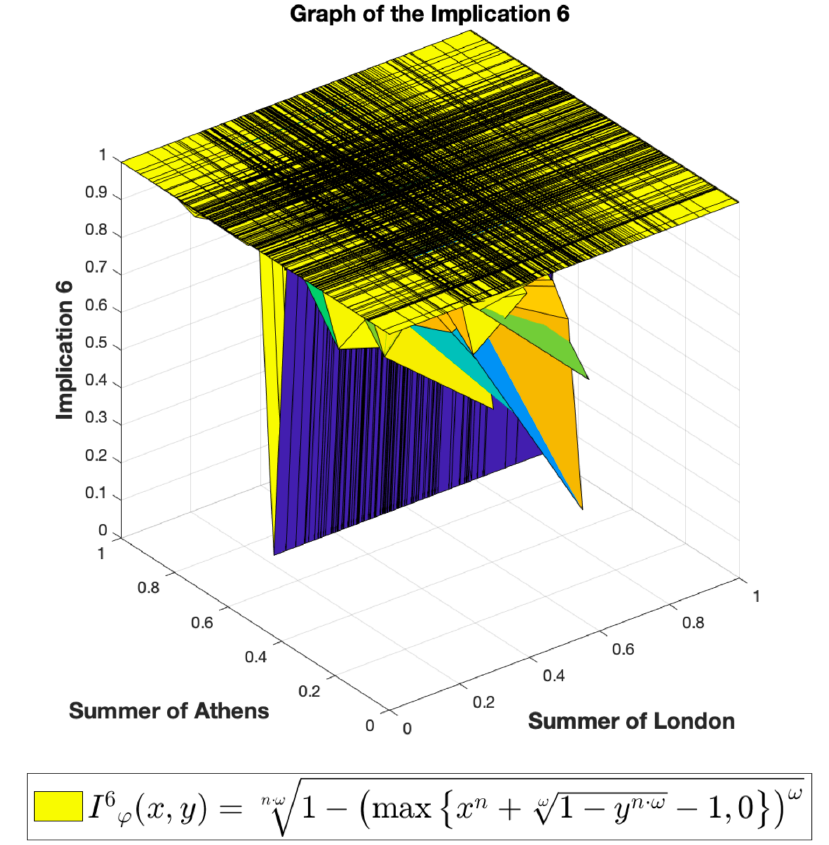
Figure 7. Graph of the Implication